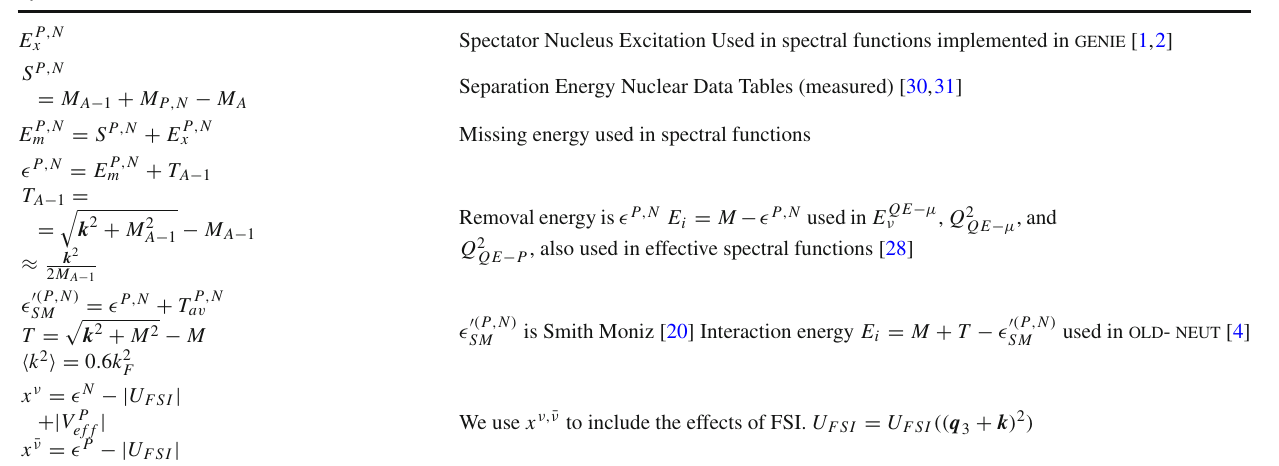
Table2 Summaryoftherelationshipsbetweenexcitationenergy E P , N x (used in genie ), separation energy S P , N , missing (missing) energy E P , N m (used in spectral function measurements), removal energy (cid:2) P , N (used in the reconstruction of neutrino energy from muon